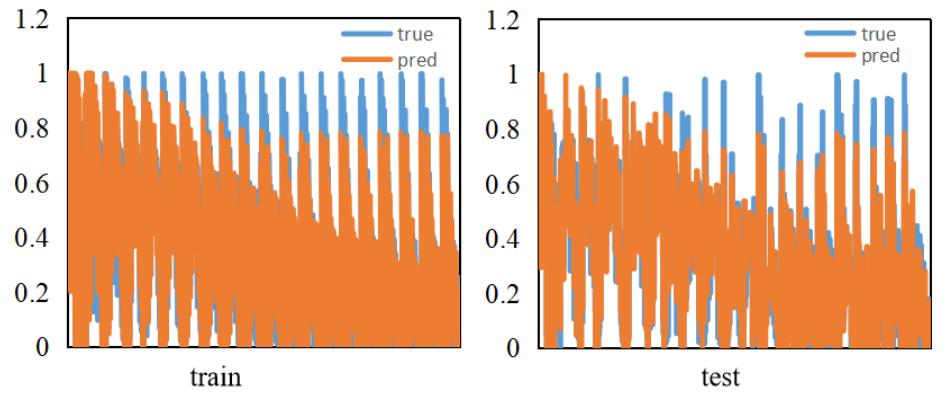
Figure 5. Comparison of actual and predicted normalized